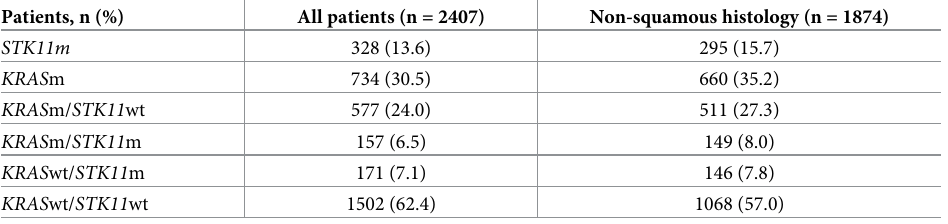
Table 2. STK11 and KRAS / STK11 mutation prevalence in all patients with metastatic NSCLC and patients with non-squamous metastatic